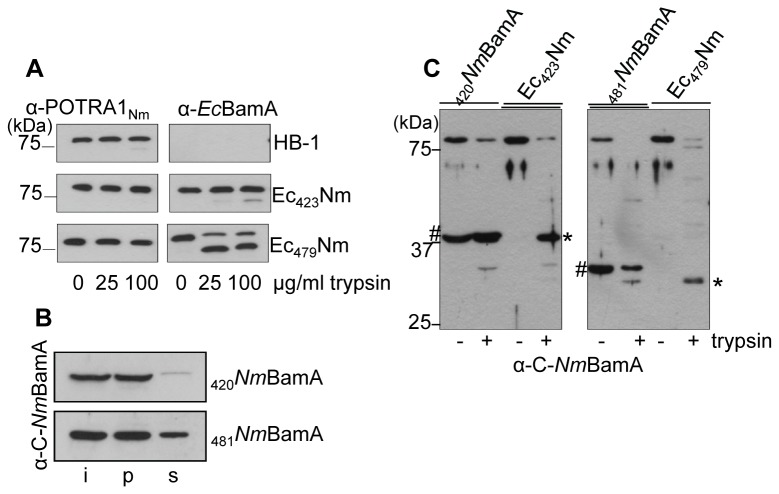
Analysis of the β-barrel domain of NmBamA.A: Intact HB-1 cells and HB-1 cells producing Ec423Nm or Ec479Nm were treated with the indicated concentrations of trypsin for 15 min and processed for immunoblotting with α-POTRA1Nm (left panels) or α-EcBamA (right panels) antibodies. B. Cell envelopes of HB-1 producing the proteins indicated at the right were treated with urea and processed for immunoblotting with α-C-NmBamA antiserum. C: Cell envelopes of HB-1 producing the proteins indicated on top were treated overnight with or without trypsin and analyzed on immunoblots with α-C-NmBamA antiserum. The # signs indicate the positions of the truncated 420
Nm BamA and 481
NmBamA variants, wheras the * signs indicate tryptic fragments derived from the chimeric Ec423Nm or Ec479Nm proteins (similar to those shown in Fig. 6B).